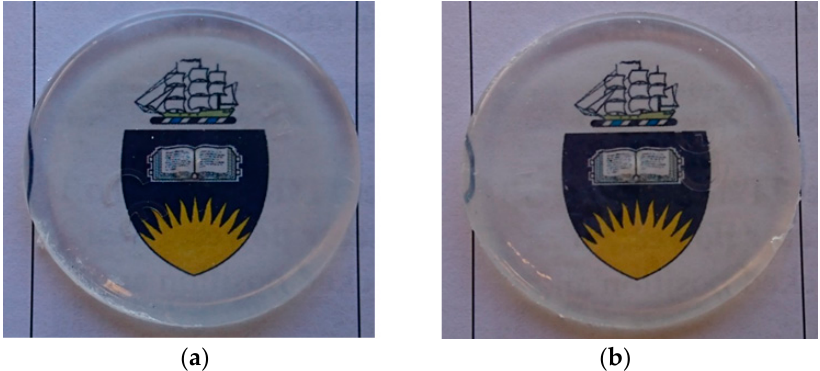
Figure 8. 50/50 + 5 wt % glycidyl methacrylate (GMA) composition after two ‐ step polymerisation: ( a ) 1 layer and ( b ) 3 layers.